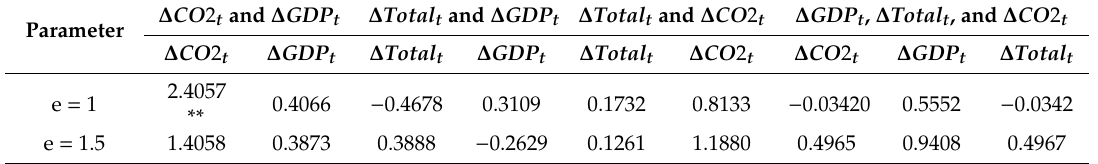
Table 8. Nonlinearity Test.